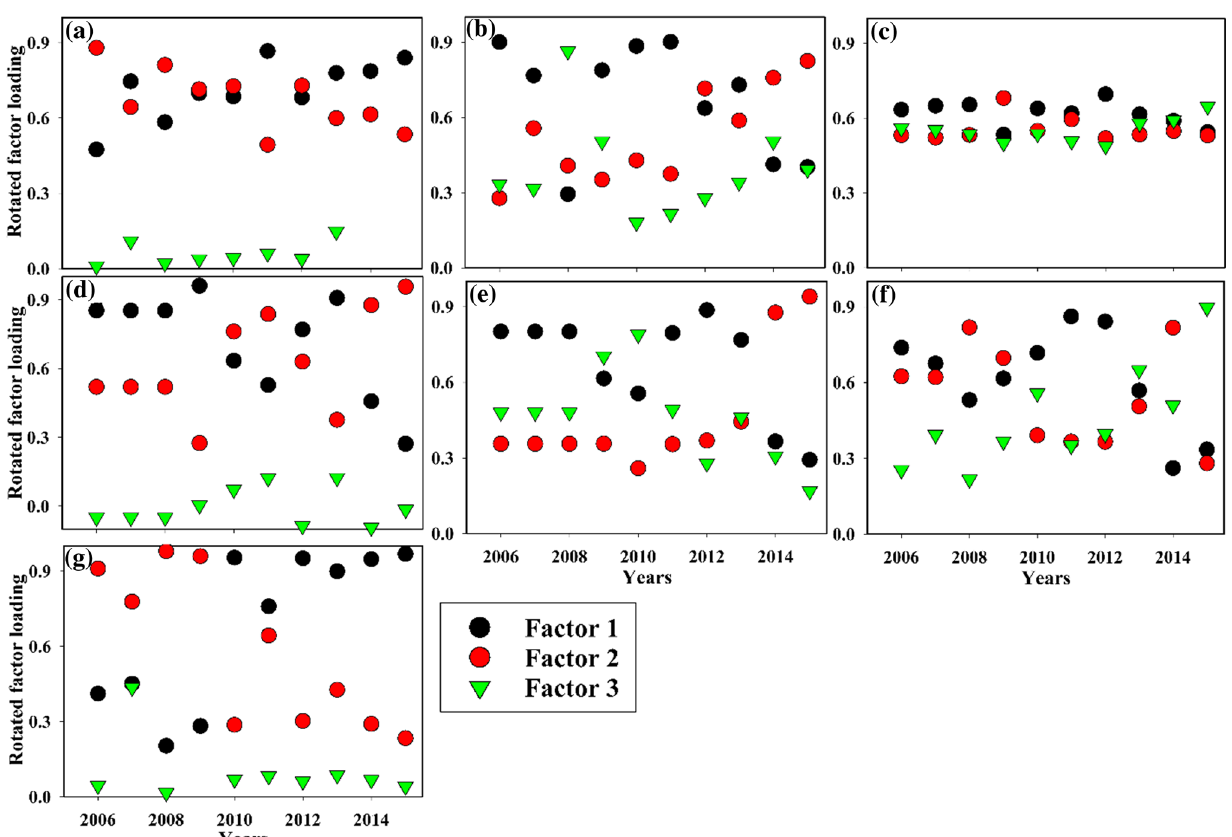
Fig. 7 Spatial and temporal variabilities of the rotated factor loading values of the three controlling factors of water quality at a Wonji, b AR_B_